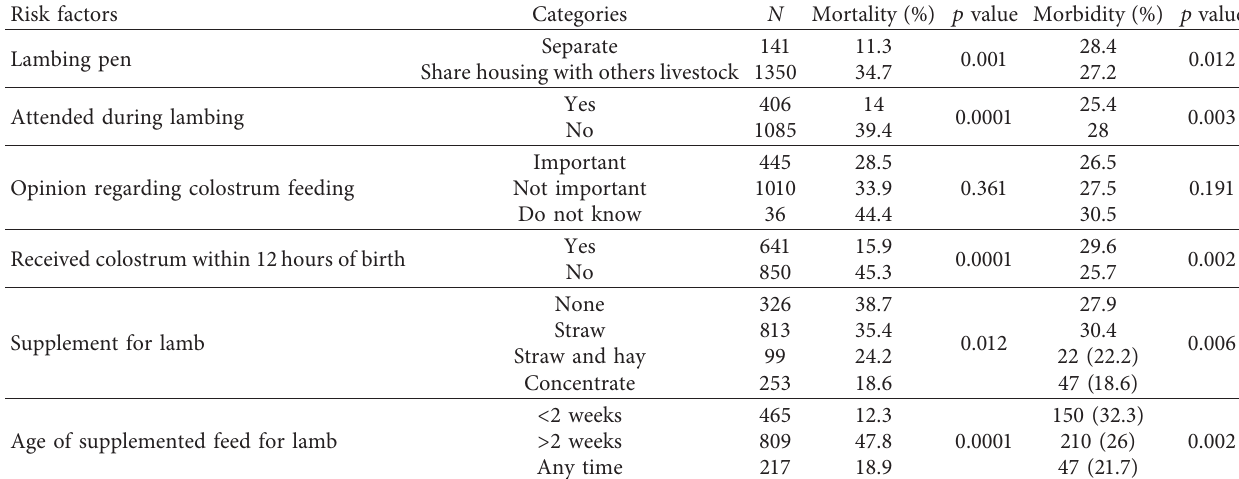
Table 6: Association of lamb management with mortality and